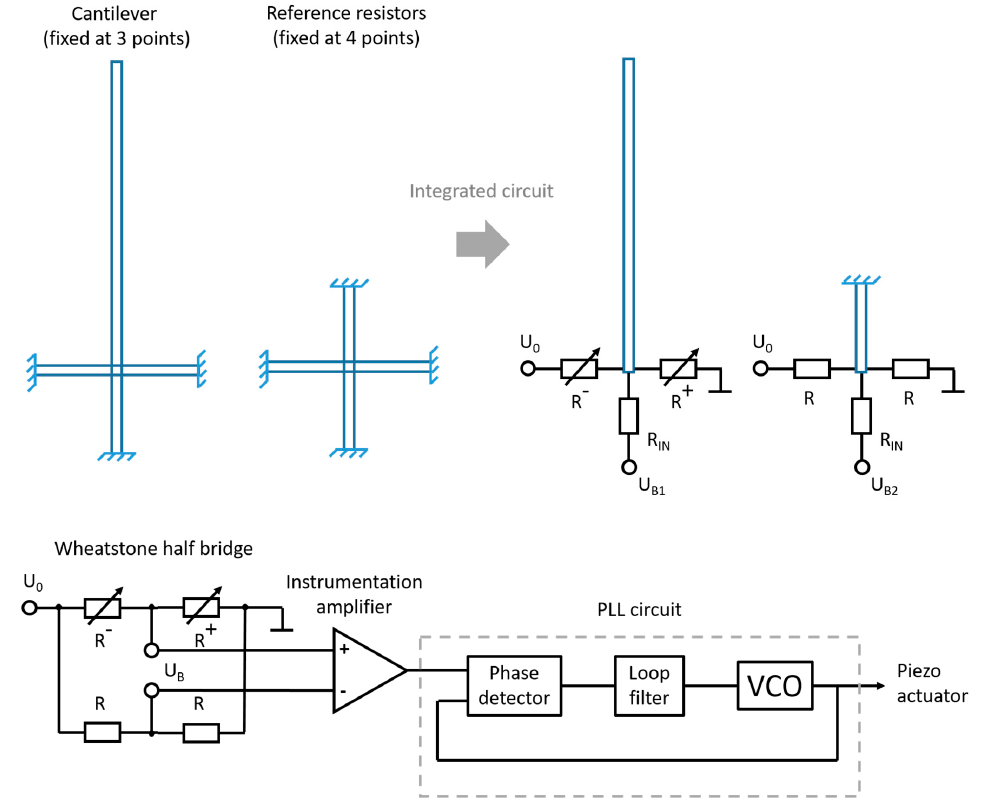
Figure 2. Electrical connections and circuit integration of the cantilever sensor.